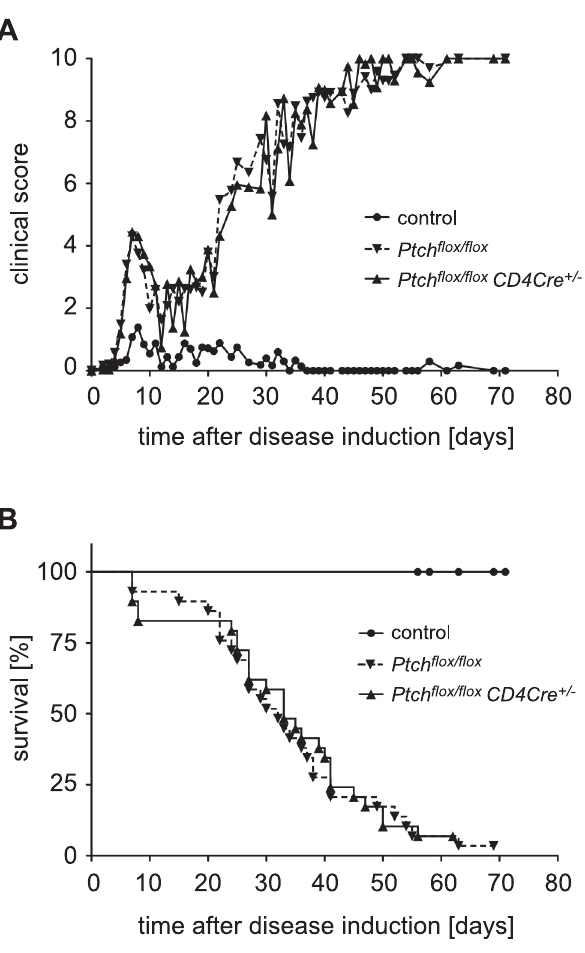
Figure 6. Morbidity and mortality after GvHD induction. GvHD was induced in irradiated Balb/c mice (8.5 Gy) by transferring 10 7 T cell- depleted syngeneic bone marrow cells plus 2 6 10 6 T cells from either Ptch flox/flox control or Ptch flox/flox CD4Cre + / 2 mutant C57BL/6 donor mice (n=29 for each genotype). Control animals received T cell depleted bone marrow only (n=13). Mice were monitored every other day for clinical symptoms (A) and survival (B). The figures show the combined data of five independent experiments. Statistical analysis of the disease courses was performed by Mann Whitney test; in the case of the survival curves the log-rank test was employed. In both cases, no statistical significant difference between both genotypes was found.